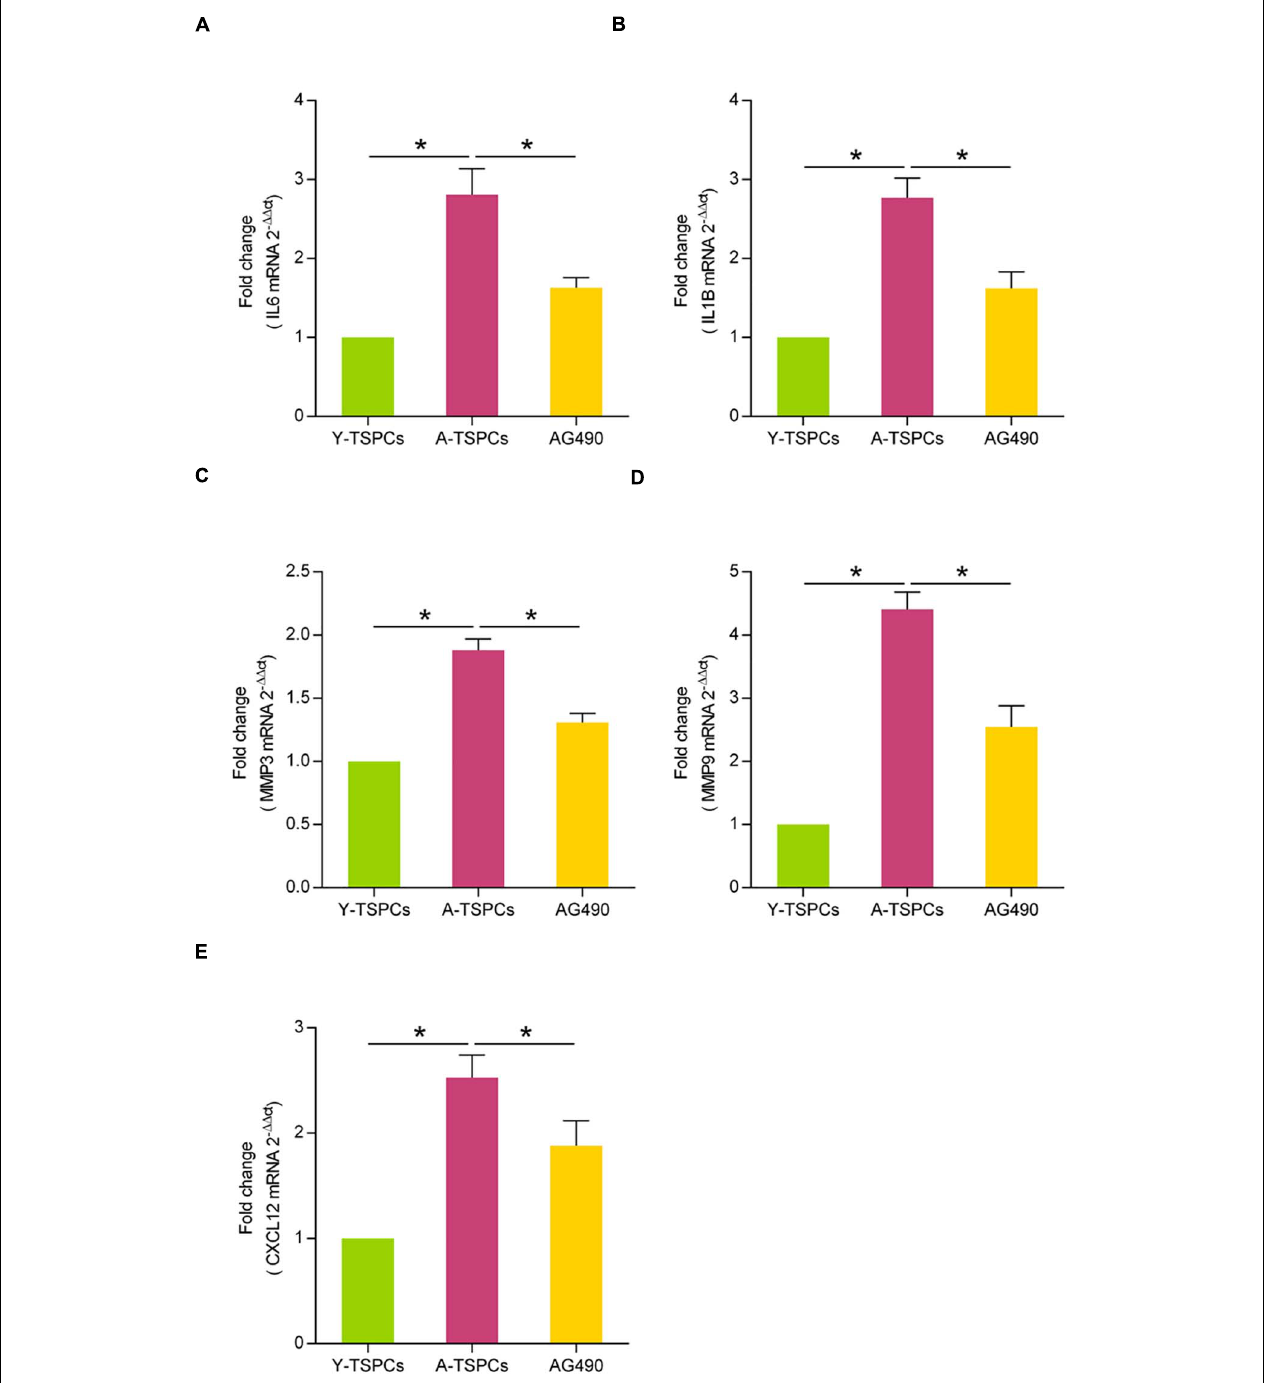
FIGURE 4 | AG490 inhibits the SASP expression in aged TSPCs. (A–E) Relative mRNA levels of representative SASP genes (IL6, IL1B, MMP3, MMP9, and CXCL12) in young, aged, and aged AG490-treated TSPCs were investigated by qRT-PCR. * P < 0.05 compared with the young or aged